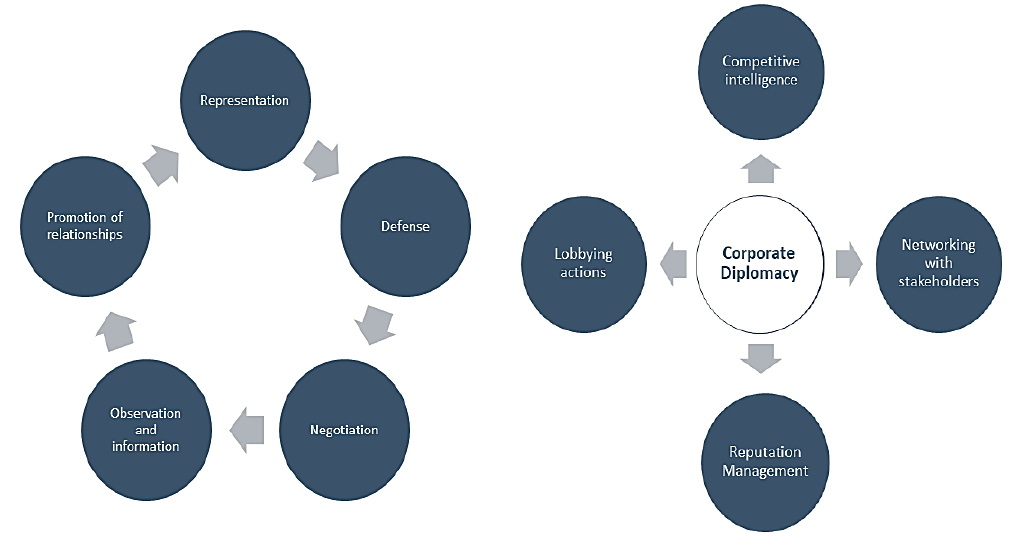
Figure 2. Traditional diplomacy functions vs. corporate diplomacy functions.